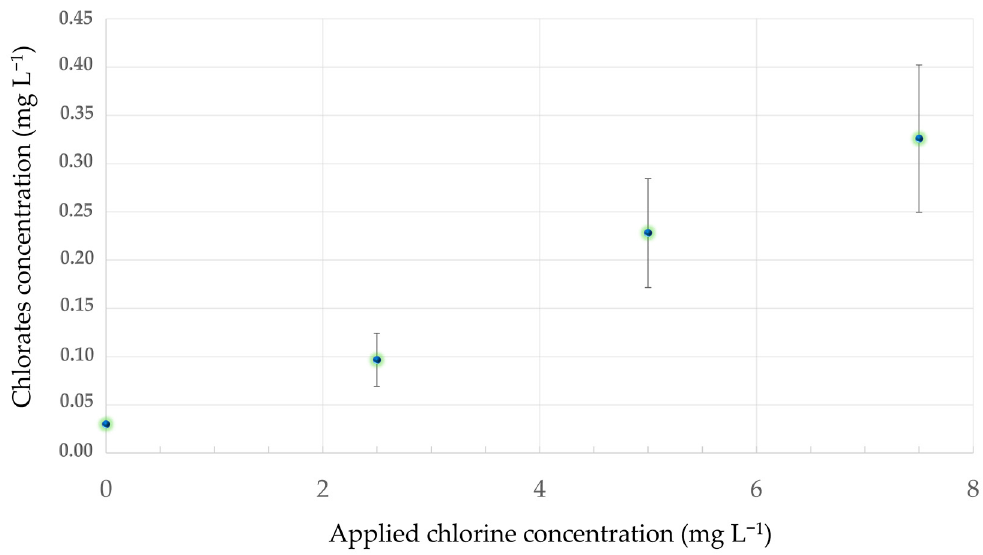
Figure 2. Chlorate residues detected in the nutrient solution of an open soilless cultivation of tomato after application of chlorine at concentrations of 2.5, 5 and 7.5 mg L − 1 . The bars represent standard deviations.